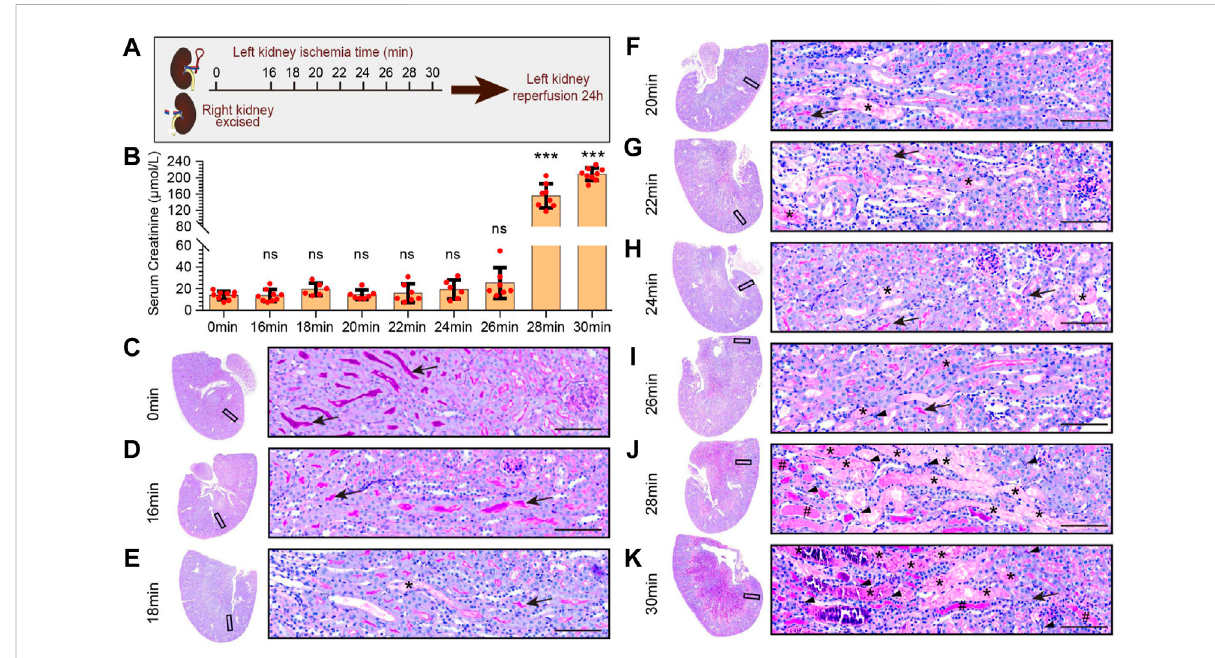
FIGURE 1 Pathological features of kidney injury at different ischemia times. (A) The experimental design of the unilateral ischemia reperfusion injury and the contralateral kidney resection AKI (uIRIx) model. Mice were randomly assigned to 9 ischemia groups based on different ischemia time of left kidney: 0 min, 16 min, 18 min, 20 min, 22 min, 24 min, 26 min, 28 min, and 30 min, and the mice were sacri fi ced 24 h after reperfusion. (B) The serumcreatininelevelsindifferentischemiagroups24 hafterreperfusion.Statisticalanalysis: fi rstly,weperformedone-wayANOVAanalysison the 9 groups, and found statistically signi fi cant differences in mean values among the samples; And then, Dunnett-t test was used to make multiple comparisons of mean differences between each ischemia group and sham group. n = 6 – 9 mice per group, ns indicates no signi fi cant, *** p < 0.001, compared to 0min group (C – K) Representative micrographs of PAS staining showed the pathological features of kidney injury at different ischemia times: 0min group (C) , 16 min group (D) , 18 min group (E) , 20 min group (F) , 22 min group (G) , 24 min group (H) , 26 min group (I) , 28 min group (J) , and 30 min group (K) . Scale bars: 100 μ m. The arrow showed the brush border of normal tubule, the asterisk (*) showed the blocked tubule, the triangle showed the in fi ltrated in fl ammatory cell, and the well sign (#) showed the protein